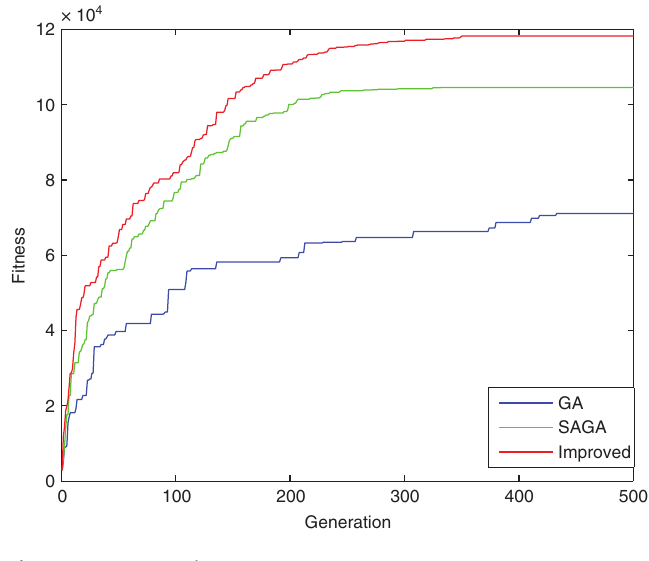
Figure 5. Data Sample 1.